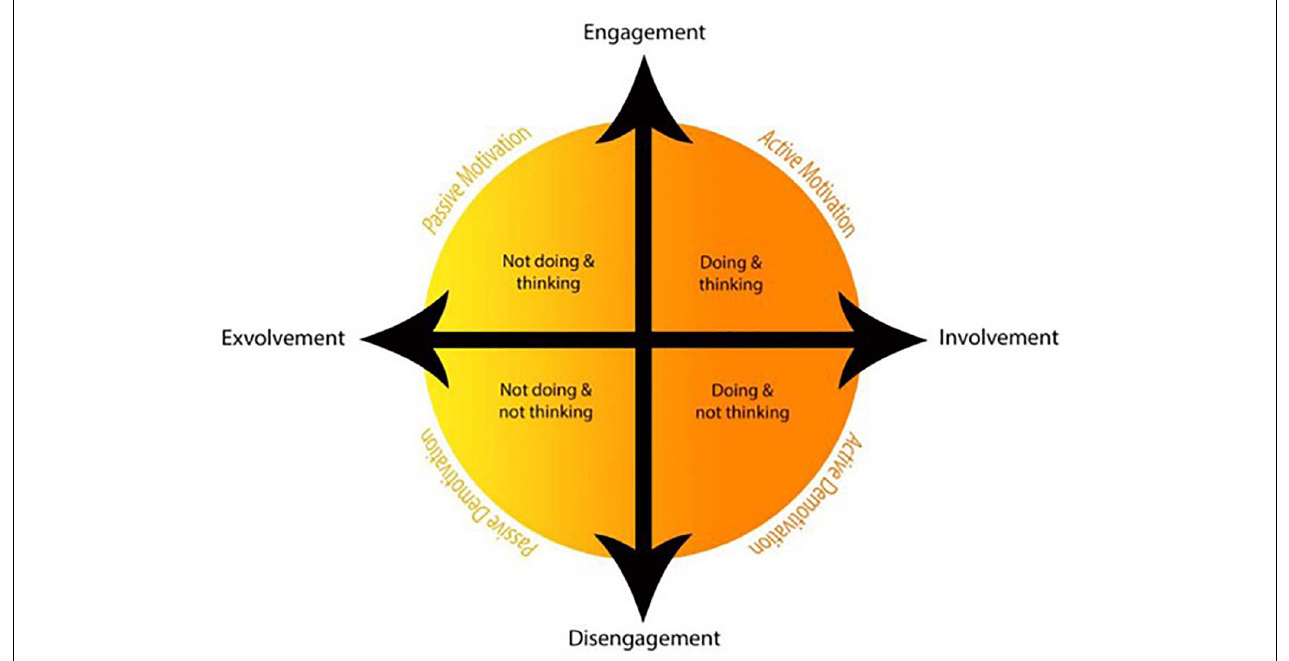
FIGURE 1 | The Dual Continuum Model of Motivation. Adapted from “Unveiling the passive aspect of motivation: insights from English language teachers’ habitus,” by Pishghadam et al. (2019b), Copyright 2019 by the IJSCL.